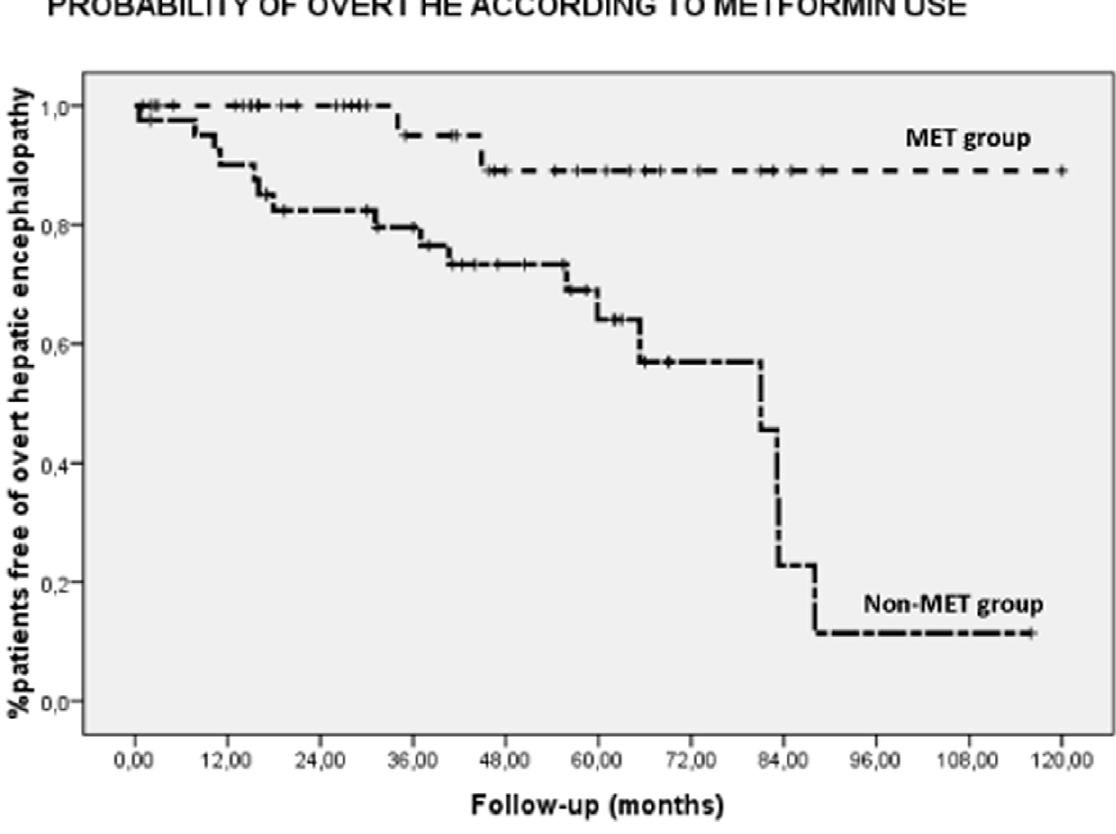
Figure 1. Kaplan Meier curve showing the impact of metformin use on hepatic encephalopathy (n=82; log Rank: 9.45; p=0.002).